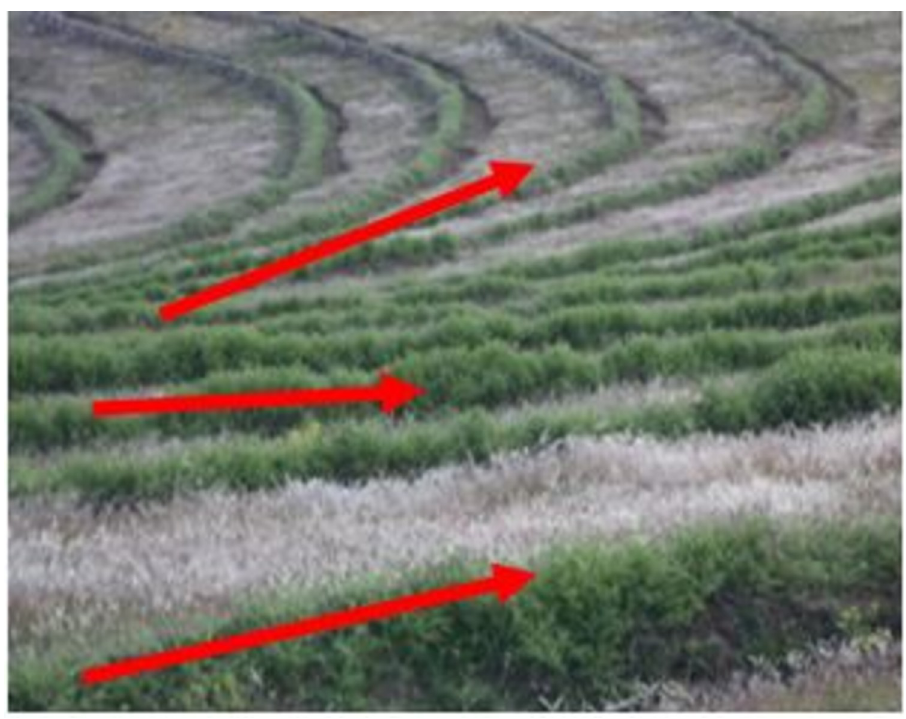
Fig 7. Stabilized bund with Desho grass .